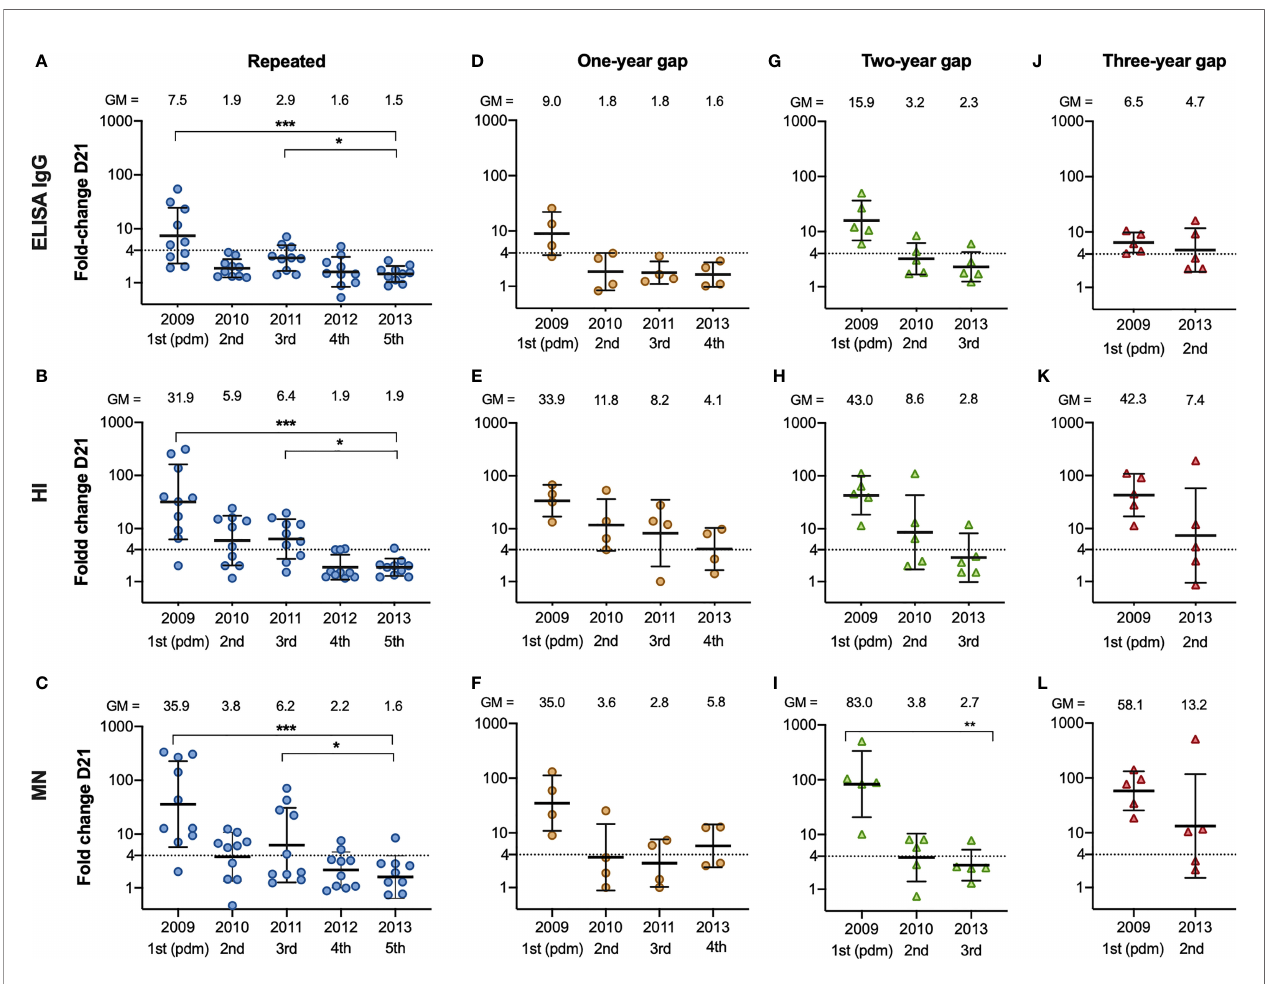
FIGURE 5 | The foldchange after vaccination from 2009/10 – 2013/14 inrepeatedly vaccinated and HCW with a one-, two-and three-year gap invaccinationsbefore vaccination in2013/14. The foldchange from pre-vaccination titres (D0) to post-vaccination titres (D21)measured in ELISA (A) , HI (B) and MN (C) in the HCWwith repeated vaccinations, one-year gap (D – F) two-year gap (G – I) and a three-year gap (J – L) in vaccinationsbeforegetting vaccinated in 2013/14. Each symbol represents an individual ELISA, HI and MNfold change. The horizontal line shows the geometric mean with geometricstandard deviation.The geometricmean isshownabove the graph, and the number of vaccinationsisshownbelow the graph. The dotted line at4 indicates seroconversion. The Friedman test was usedfor detecting differences within the different subgroups, with Dunn´stest for multiplecomparisonsand the fold change in 2013/14 as the reference timepoint. ***P < 0.001, **P < 0.01, *P <